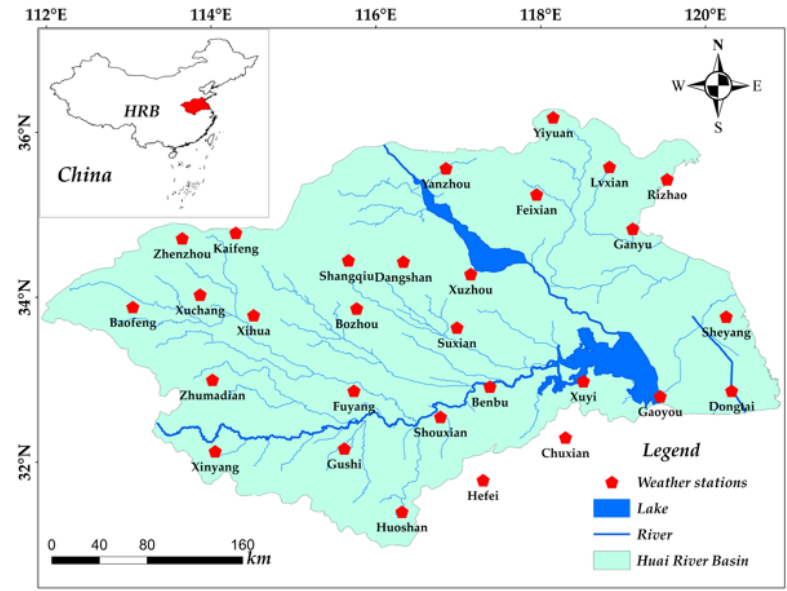
Figure 10. Distribution of weather stations in or around the